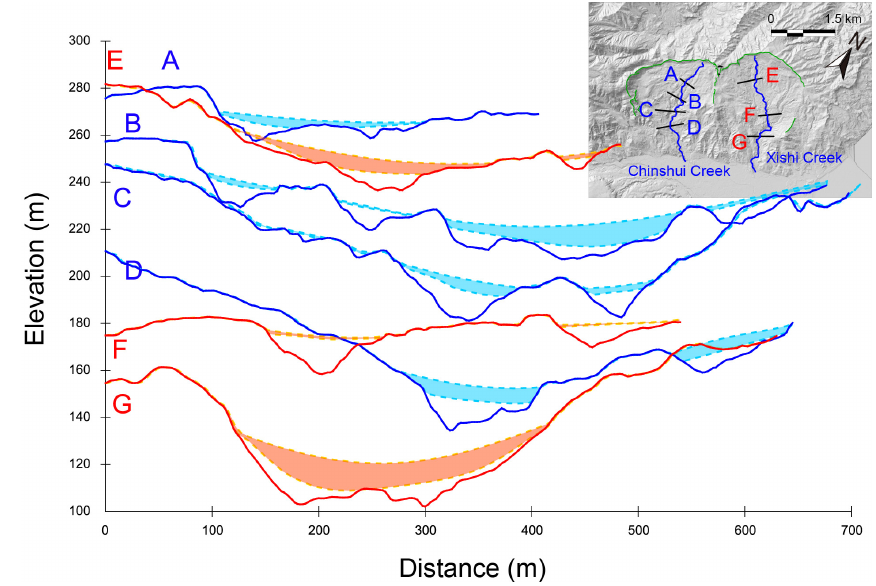
Figure 11. Cross sections of the river valleys situated in the landslide area. The shaded area indicates the possible datum ranges obtained within various search radii (D1 and D2 in Fig. 9b). If the current elevation is lower than the possible paleodatum, this depth represents the amount of the incision. The upper and lower bounds are indicated by the semiopaque dashed line. The locations of the cross sections in the landslide area are shown in the inset. The original ground surface is extracted from the lidar